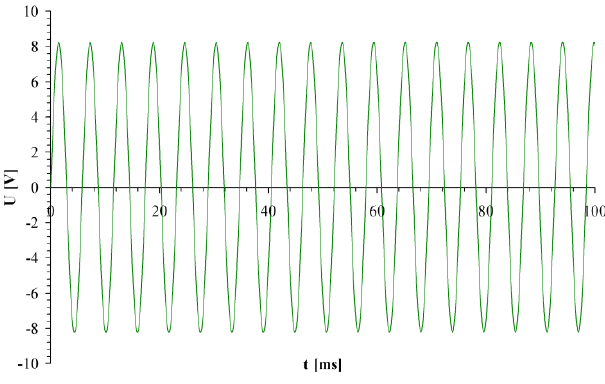
Fig. 4. An example of an analogue signal that carries information only through frequency